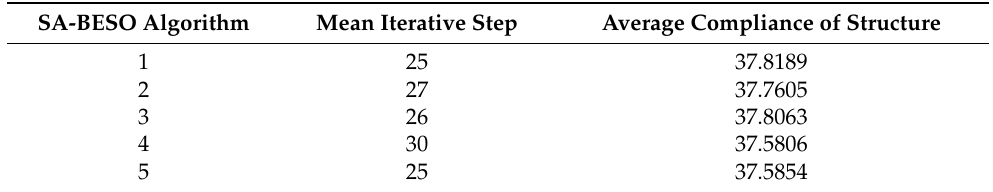
Table 3. The SA-BESO algorithm for the loaded knee structure—the optimization result data when deletion rate being